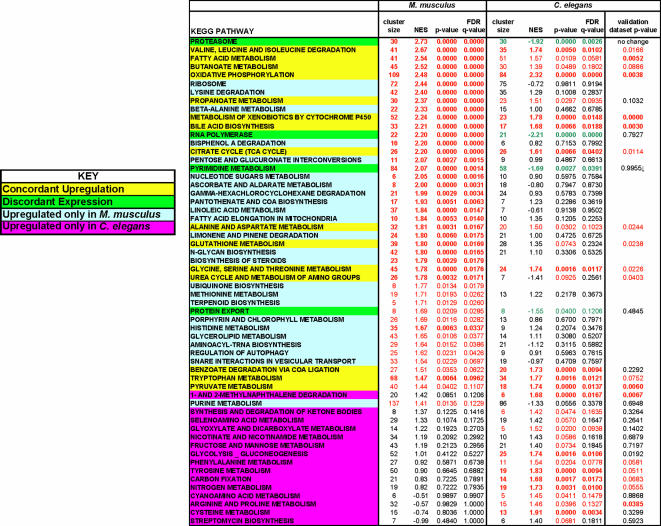
Metabolic Pathway Alterations Are Seen by Expression Profiling in B6.Alb/cre,Pdss2loxP/loxP Mouse Liver.Global genome expression profiling in B6.Alb/cre,Pdss2loxP/loxP mouse liver identifies concordant transcriptional alterations interpretable at the level of multiple metabolic pathways, which suggest significantly altered intermediary metabolism occurs despite an apparent absence of symptomatic disease. Extensive evolutionary concordance in upregulation of key biochemical pathways is seen in primary mitochondrial dysfunction, both in this mammalian Pdss2 liver-conditional knockout model of coenzyme Q deficiency and in a previously reported C. elegans gas-1(fc21) missense mutant model of primary complex I dysfunction [21]. Biochemical pathways as curated from the KEGG online database (http://genome.jp.kegg) are indicated with the # of genes in each pathway (cluster size), normalized enrichment score (NES), statistical significance of altered pathway expression between mutant and wildtype controls (p-value), and false positive percentage in the form of a false discovery rate (FDR q-value) according to GSEA. Pathways are ranked by descending NES in the Pdss2 mutant (left data column). Comparison to previously reported complex I gas-1(fc21) missense C. elegans mutant dataset (middle data column) and a “validation” C. elegans dataset of 8 different complex I, II, and III missense and RNAi-interference generated mutants (right data column) is indicated by differential highlights [21]. Font color denotes a pathway as relatively upregulated (red), downregulated (green), or unchanged (black).